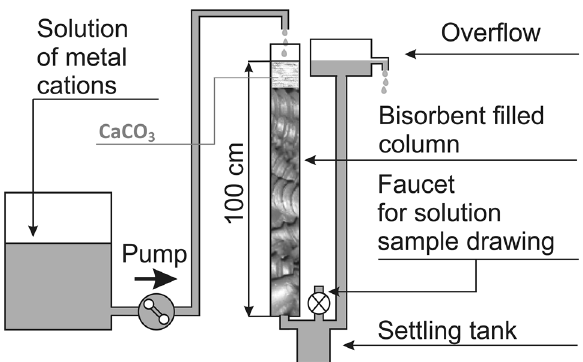
Figure 1. Diagram showing the sorption assemblie for a flow-through